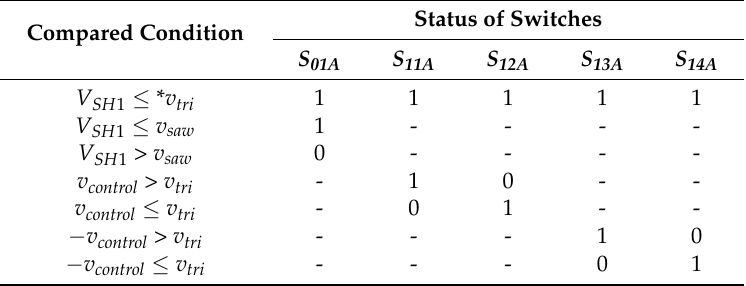
Table 1. A truth table of switching signal generation in module 1.